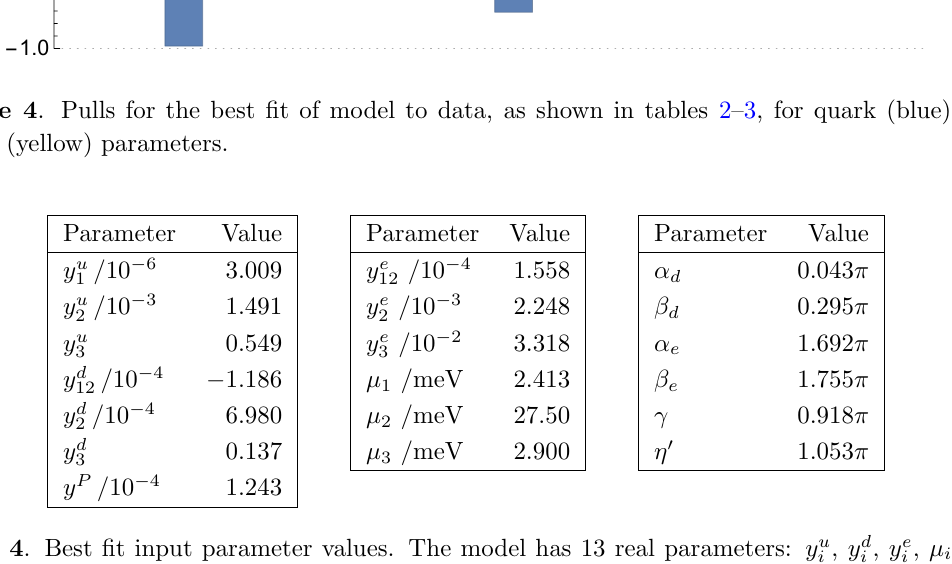
2 (cid:25)= 3, there are six additional free phases: (cid:17) 0 , (cid:11) d;e (cid:0)